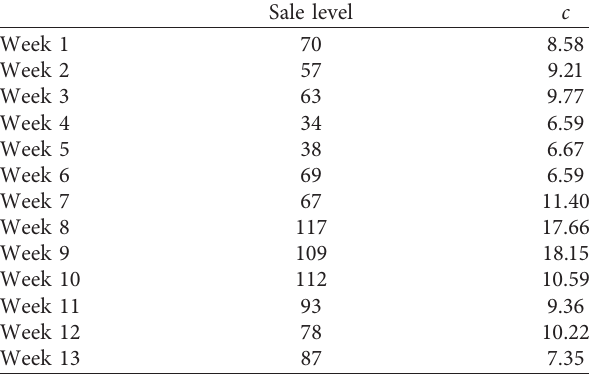
Table 1: Sale level and comments emotion